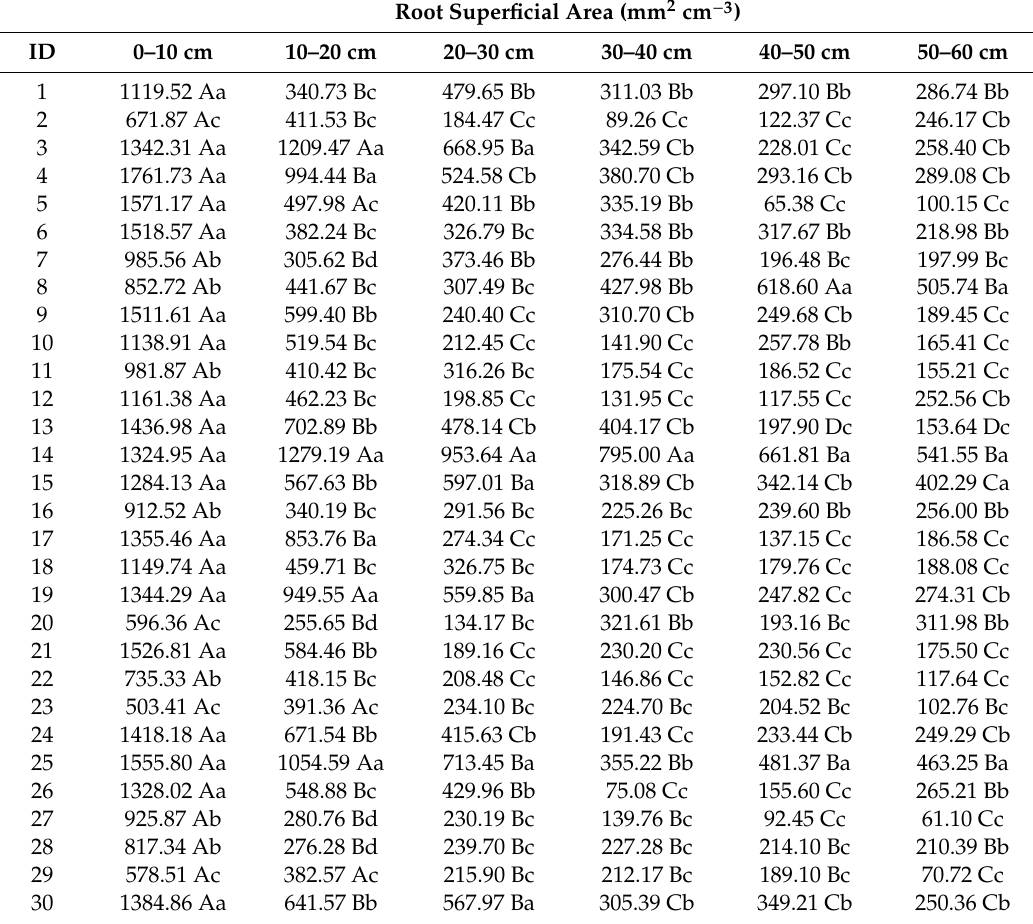
Table 5. Average root superficial area of 43 C. canephora genotypes in six soil